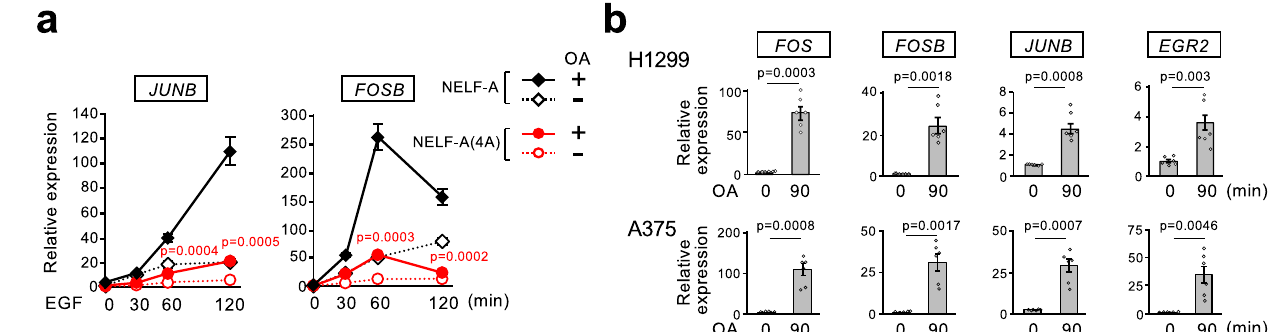
Fig. 7 | PP2A-mediated dephosphorylation of NELF-A suppresses IEG expres- sion. a , b In ( a ), HEK293-WT (black lines) and -4A (red lines) cells were stimulated with EGF (20ng/ml) for the indicated times in the presence or absence of OA (400nM).In ( b ),H1299 and A375cells weretreatedwith OA for90min. a , b Levels